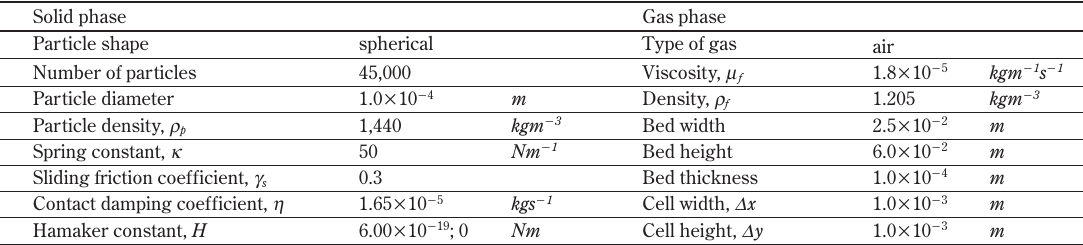
* . The wall properties such as κ , γ and η are the same as those for